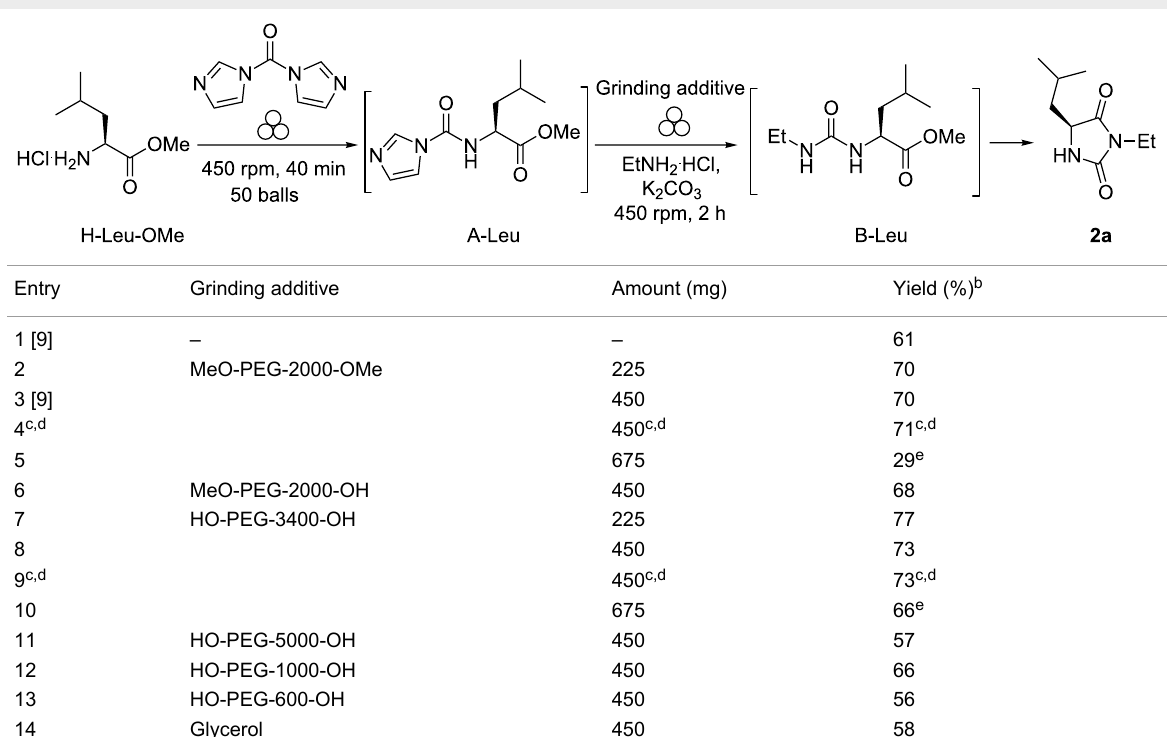
Table 1: Screening of grinding additives using ( L) -H-Leu-OMe . HCl as benchmark for the preparation of compound 2a . a